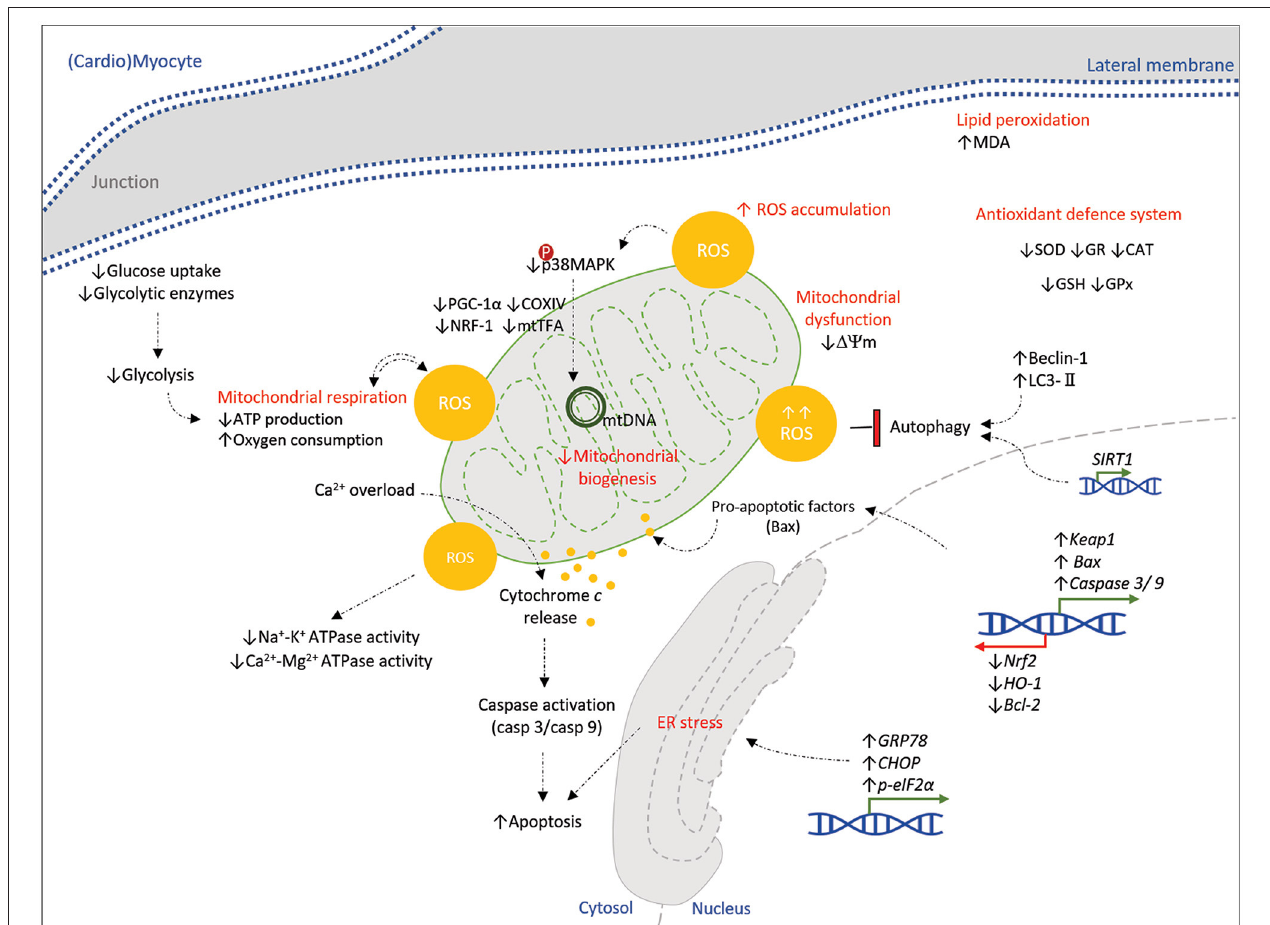
FIGURE 3 | Schematic representation of the molecular pathways affected by mycotoxins in a (cardio)myocyte. Mycotoxins (AFB 1 , OTA, T-2, DON, and ZON) show toxicity on a (cardio)myocyte, principally by excessive oxidative stress and ROS accumulation. Alterations in mitochondrial bioenergetics, mitochondrial dysfunction, transcription of stress/apoptotic genes, and ER stress orchestrate the cell damage and apoptosis. Dysregulation of the antioxidative system and protective pathways (autophagy) would enhance these mechanisms of toxic myopathy. Down- and upstream signaling pathways that might be affected by mycotoxins in a myocyte are still unknown to be represented here; hence it is highly suggested to be determined by further studies. Green and red arrows (blocked line) indicate activation and inhibition,